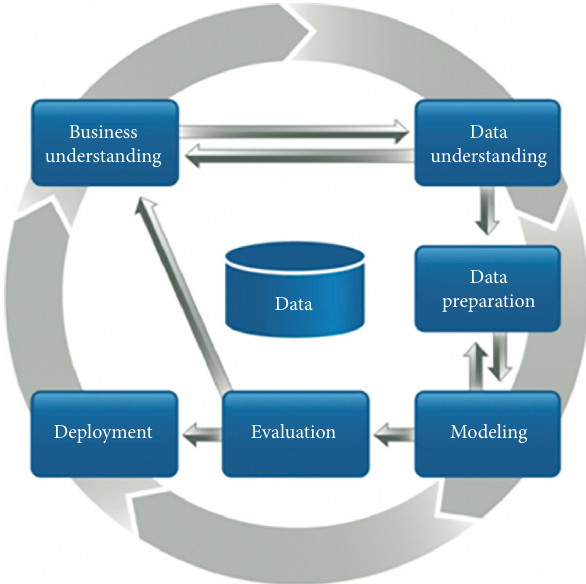
Figure 2: CRISP data mining